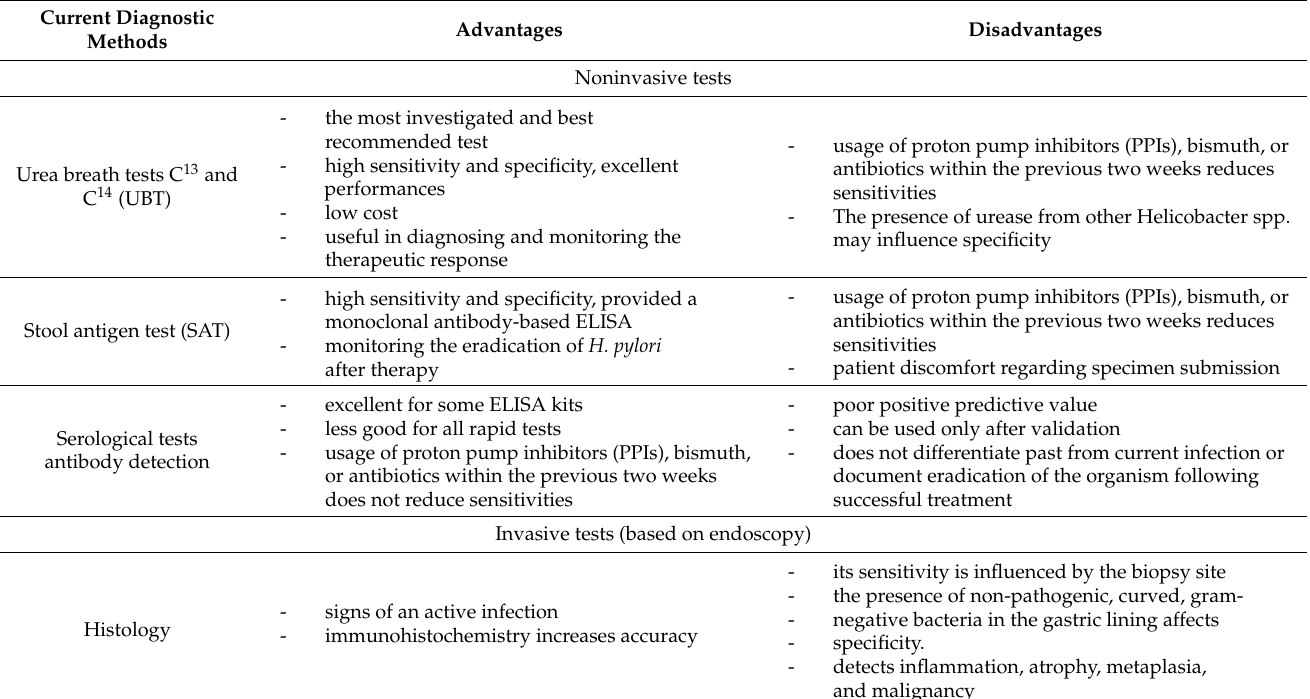
Table 1. The main advantages and disadvantages of invasive, noninvasive, and innovative nano- technological based